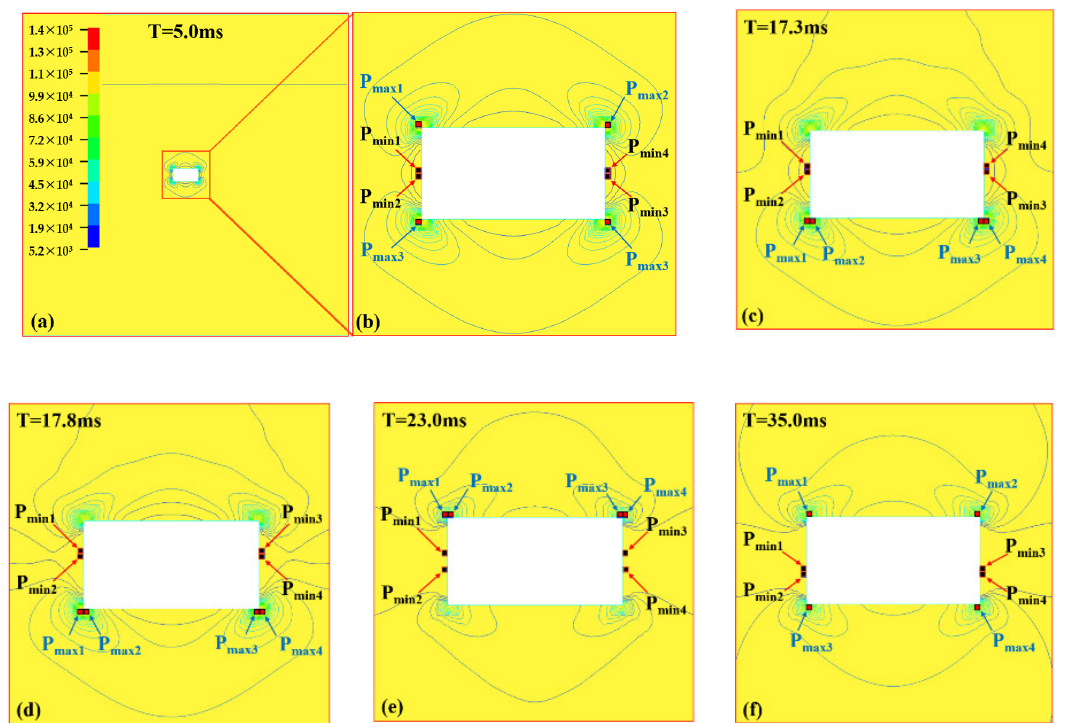
Figure 9. Contour lines of strain energy density (SED) (model I). Note: units are in J / m 3 . (( a ): T=5.0 ms; ( b ): a local enlarged view; ( c ): T=17.3 ms; ( d ): T=17.8 ms; ( e ): T=23.0 ms; ( f ): T=35.0 ms)